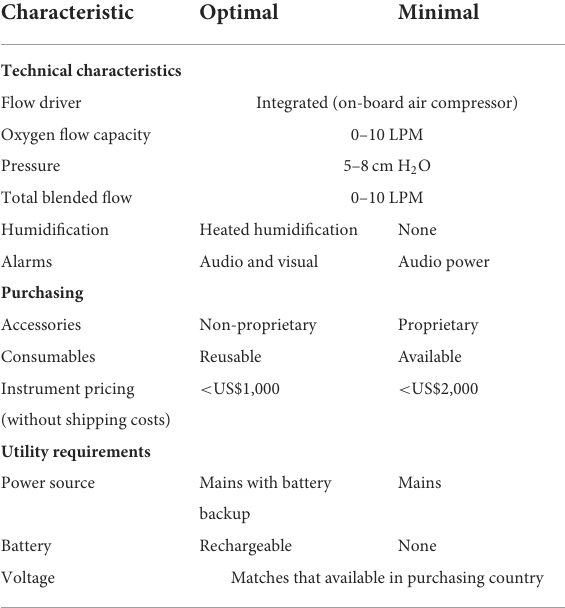
TABLE 1 Features from the UNICEF target product profile for neonatal continuous positive airway pressure for use in low- and middle-income countries